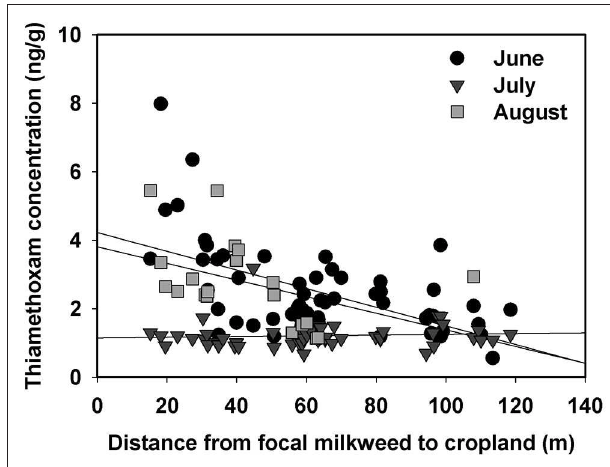
FIGURE 5 | Relationship between distance separating focal plants from cropland and concentration of the neonicotinoid thiamethoxam associated with milkweed leaves at one of our sites, Prophetstown. Each data point is an individual plant sample for June, July, or August.